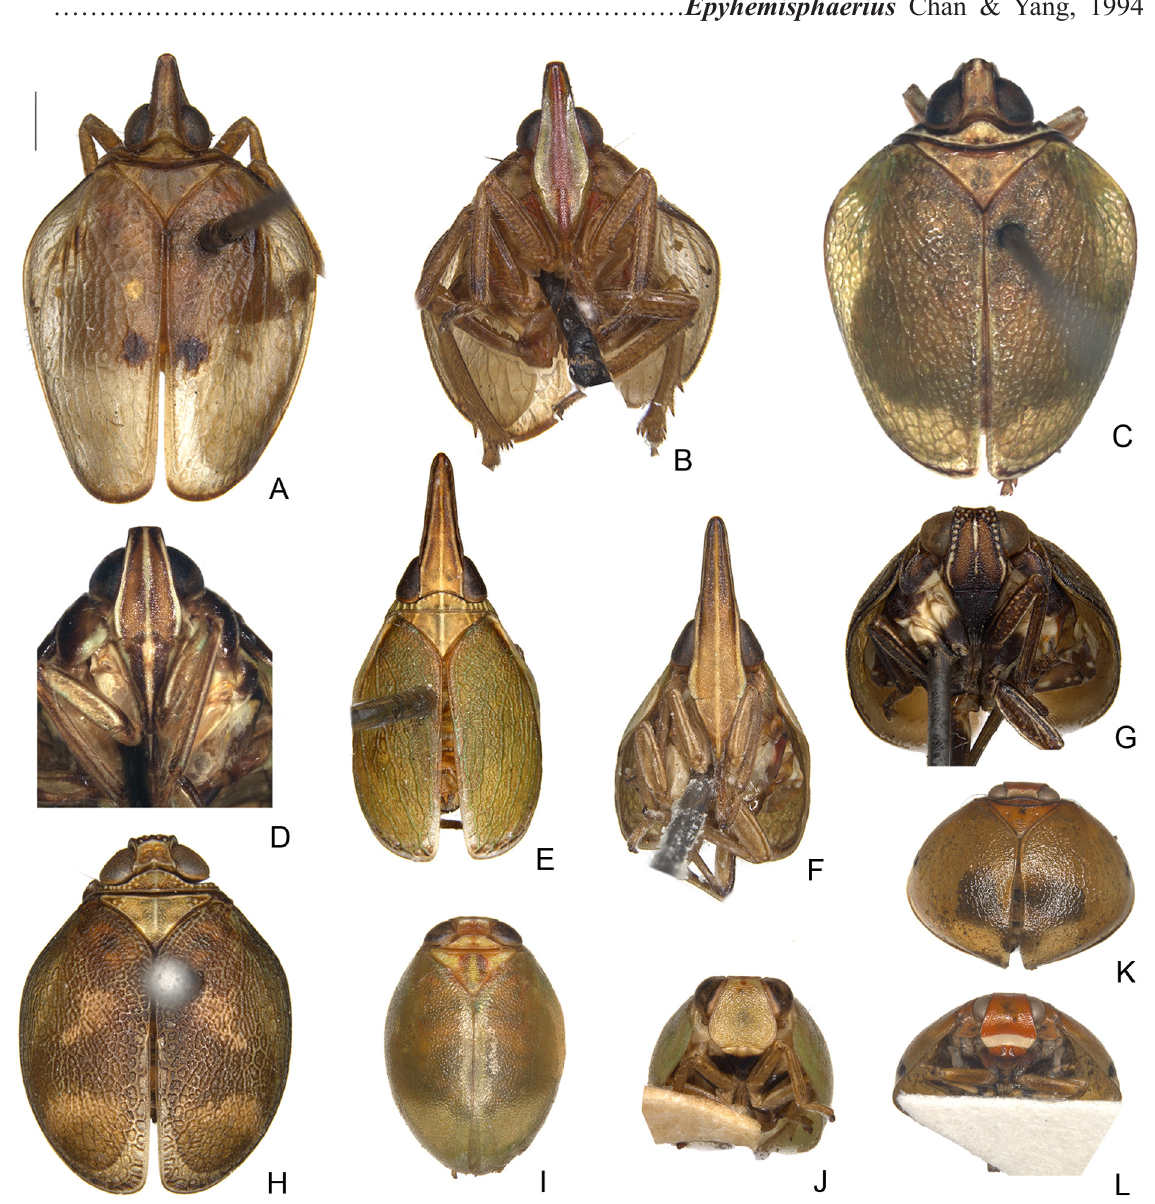
Fig. 1. Hemisphaerini. A–B . Macrodaruma pertinax Fennah, 1978. A . Habitus, dorsal view. B . Habitus, ventral view. — C–D . Neogergithoides tubercularis Sun, Meng & Wang, 2012. C . Habitus, dorsal view. D . Metope and clypeus, facial view. — E–F . Choutagus longicephalus Zhang, Wang & Che, 2006. E . Habitus, dorsal view. F . Habitus, ventral view. — G–H . Gergithoides carinatifrons Schumacher, 1915. G . Habitus, ventral view. H . Habitus, dorsal view. — I–J . Hemisphaerius lysanias Fennah, 1978. I . Habitus, dorsal view. J . Metope and clypeus, facial view. — K–L . Rotundiforma nigrimaculata Meng, Wang & Qin, 2013. K . Habitus, dorsal view. L . Metope and clypeus, facial view. Scale bar = 1